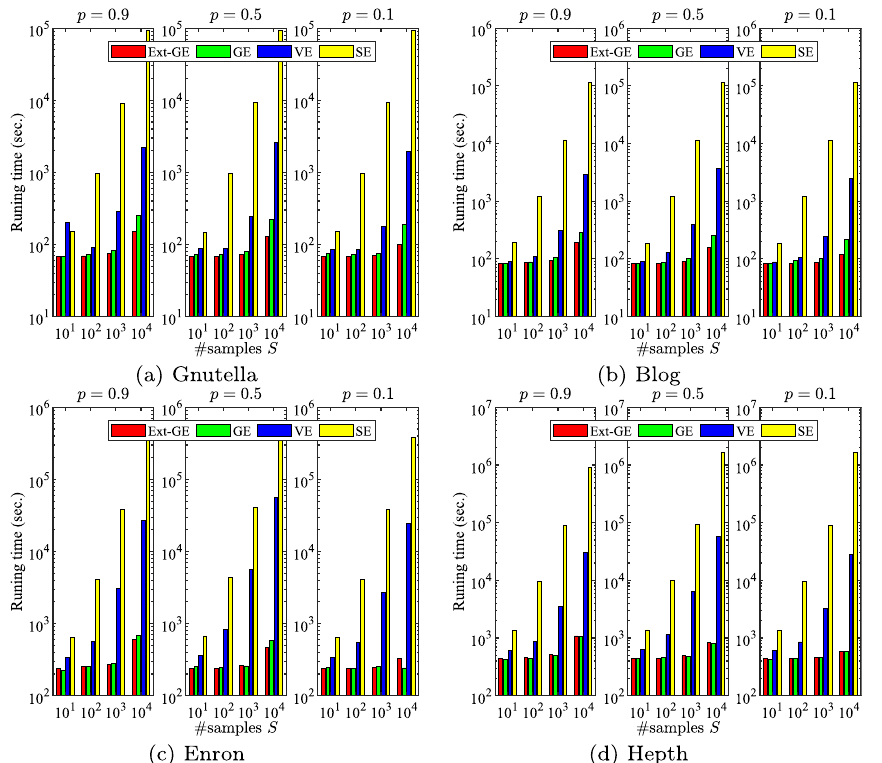
Fig. 8 Running time up to outputting the ensembled similarity matrix